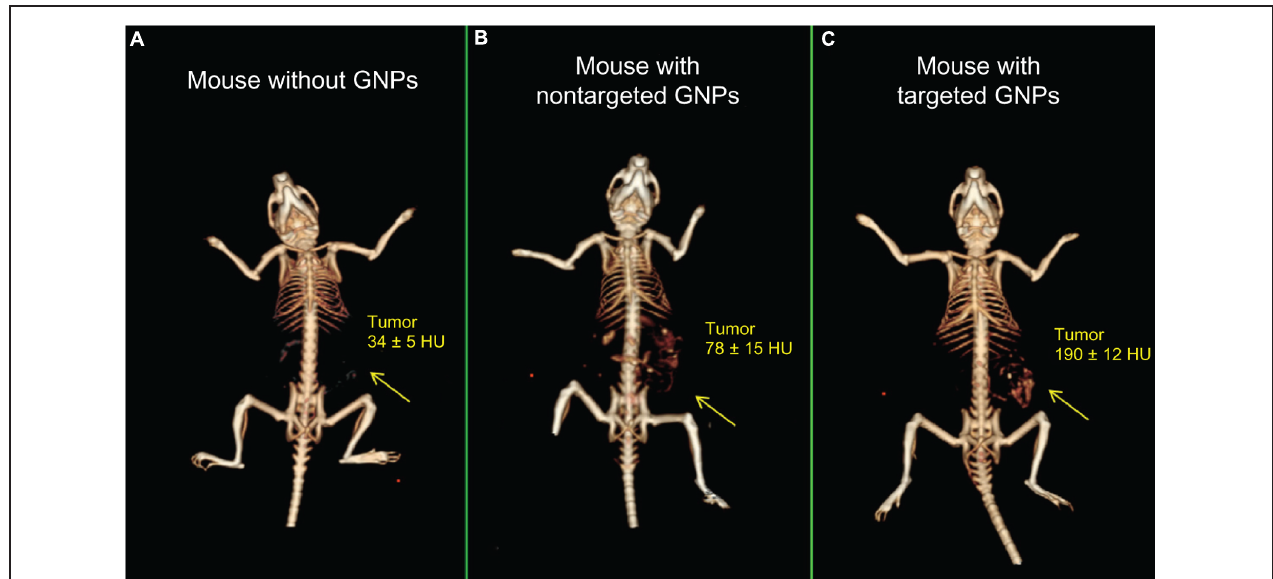
FIGURE 10 | 3D micro-CT reconstructions of mice with EGFR-expressing tumors. Mice were injected with (A) saline, (B) non-targeted gold nanoparticles, or (C) EGFR-antibody targeted gold nanoparticles. Increased CT enhancement was seen for both types of nanoparticles, but targeted nanoparticles showed significantly higher enhancement than non-targeted controls. Reprinted from with permission from (Reuveni et al., 2011a)